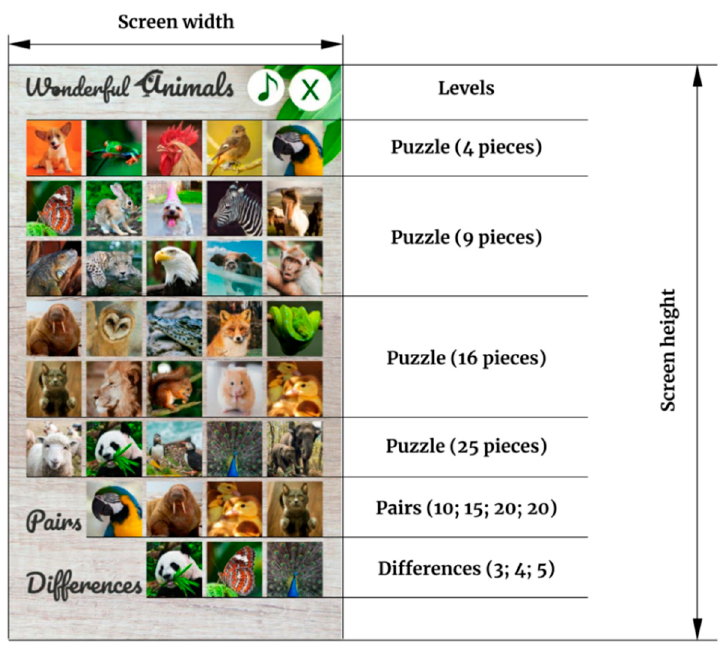
Figure 1. Main menu of the app Wonderful Animals . Puzzles are the first and main part of the game and they are grouped in four levels of complexity. Task complexity evaluation is based on the assumption that the more complex task that is connected with the higher probability that the task will be difficult to perform, and the mental effort and possibility of errors will increase [28]. The first level has five puzzles consisting of four pieces and they are shown in the first row of the main menu; the second level has 10 puzzles consisting of nine pieces (icons in the second and third row of the main menu); the third level contains 10 puzzles consisting of 16 pieces (icons in the fourth and the fifth row of the main menu); finally, the fourth level consists of five puzzles with 25 pieces each (icons shown in the sixth row of the main menu). When a player has tapped (chosen) one of the puzzles, pieces of that puzzle are shown on the